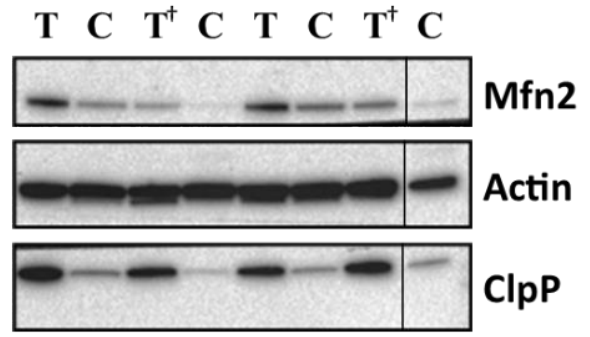
Figure 1. Representative western blotting of Mfn2 and ClpP proteins in bladder tissues. Proteins levels are referred to Actin content (loading control). T, lesional tissue (Tumor); C, adjacent non- lesional tissue (Control). † , high-risk NMIBC patients. The grouping of blots is cropped from different parts of the same gel.